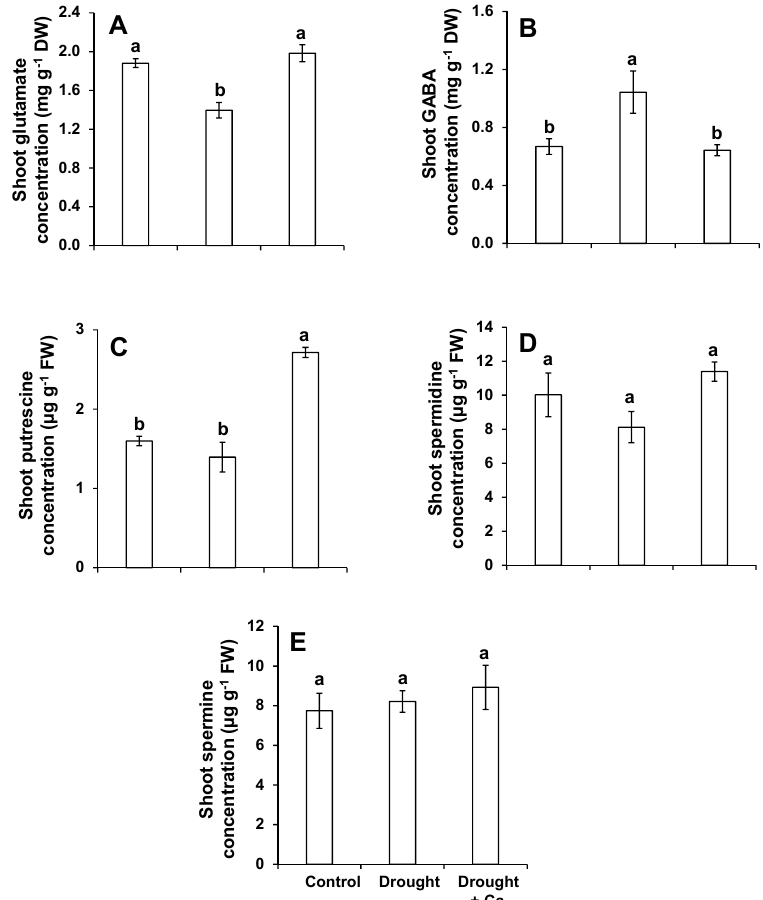
Figure 5. Influence of foliar application of Ca 2+ on shoot glutamate, GABA, and polyamine concentrations in sugar beet plants exposed to drought stress. ( A ) Shoot glutamate concentration; ( B ) shoot GABA concentration; ( C ) shoot putrescine concentration; ( D ) shoot spermidine concentration; and ( E ) shoot spermine concentration. Plants were grown in pots for a duration of 8 weeks. Five-week-old sugar beet plants were kept at 90% field capacity as control or exposed to drought stress (30% field capacity) for a duration of 3 weeks. Ca 2 + was applied at BBCH14 and BBCH18 in concentration of 5 L ha − 1 corresponding to 540 g Ca ha − 1 . Leaves and beetroot were harvested at 60 days after sowing for metabolite analysis. Bars indicate means ± SEM. Different letters denote significant differences according to ANOVA followed by SNK test ( p < 0.05; n = 6). 2.5. Foliar Application of Ca 2+ Regulated the Glutathione Pool under Drought Stress Balancing the redox state via glutathione pool is very critical under drought induced-oxidative stress [11]. Therefore, we measured both reduced (GSH) and oxidized (GSSG) glutathione, and calculated the GSSG/GSH ratio in leaves of control, drought stress alone and drought stress plants which did receive Ca. The GSH concentration was decreased under drought when compared to the control condition (Figure 6A). Interestingly, foliar application of Ca 2+ significantly enhanced the concentrations of GSH in leaves under drought stress to a similar level of that in control (Figure 6A). As expected, the concentration of GSSG and its ratio to GSH (GSSG/GSH) were increased under drought alone compared to the control (Figure 6B,C). However, Ca 2+ treatment strongly reduced their level to the same level of control plants (Figure 6B,C). We further examined the expression level of glutathione reductase ( BvGR ) as a key gene for recycling the GSSG to GSH for balancing the redox potential under stress conditions [11]. The expression of this gene was slightly, but not significantly,